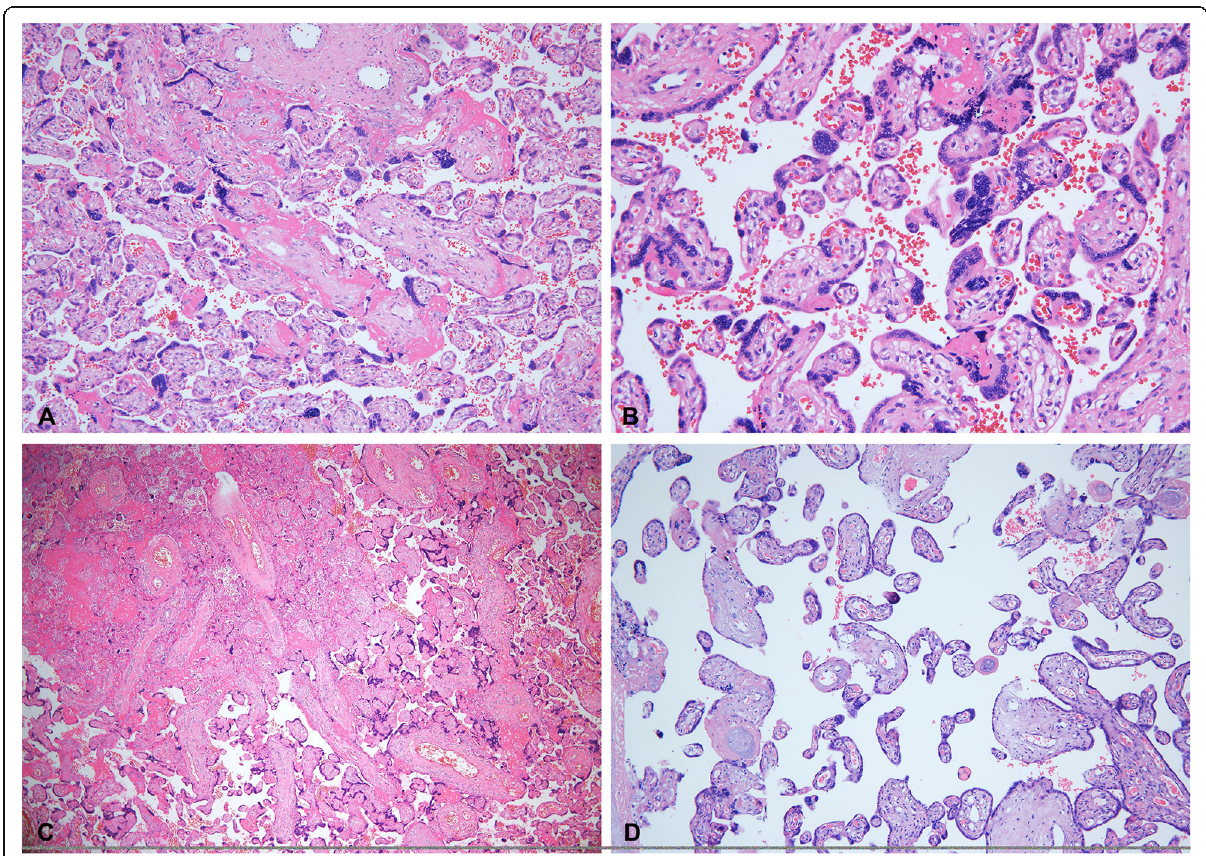
Fig. 1 Microscopy of the placentas. a , Low power view with the chorionic plateof case 3 (39 +1 weeks gestation). Increased focal perivillous fibrin depositions and increased syncytial knots were presented (H&E, original magnifications× 100). b , Close up view of increased syncytial knots in the terminal villi with the chorionic plate of case 3 (H&E, original magnifications× 200). c , Low power view with the chorionic plate of case 2(39 +5 weeks gestation). Central placental infarct was presented (H&E, original magnifications× 40). d , Low power view with the chorionic plate of case 8(37 +6 weeks gestation). Distal villous hypoplasia was presented (H&E, original magnifications×